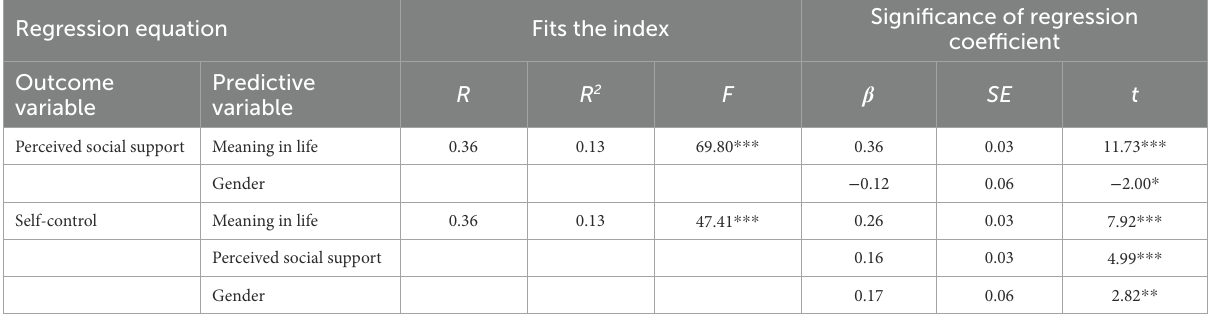
TABLE 2 Analysis of the mediating role of perceived social support between meaning in life and self-control.